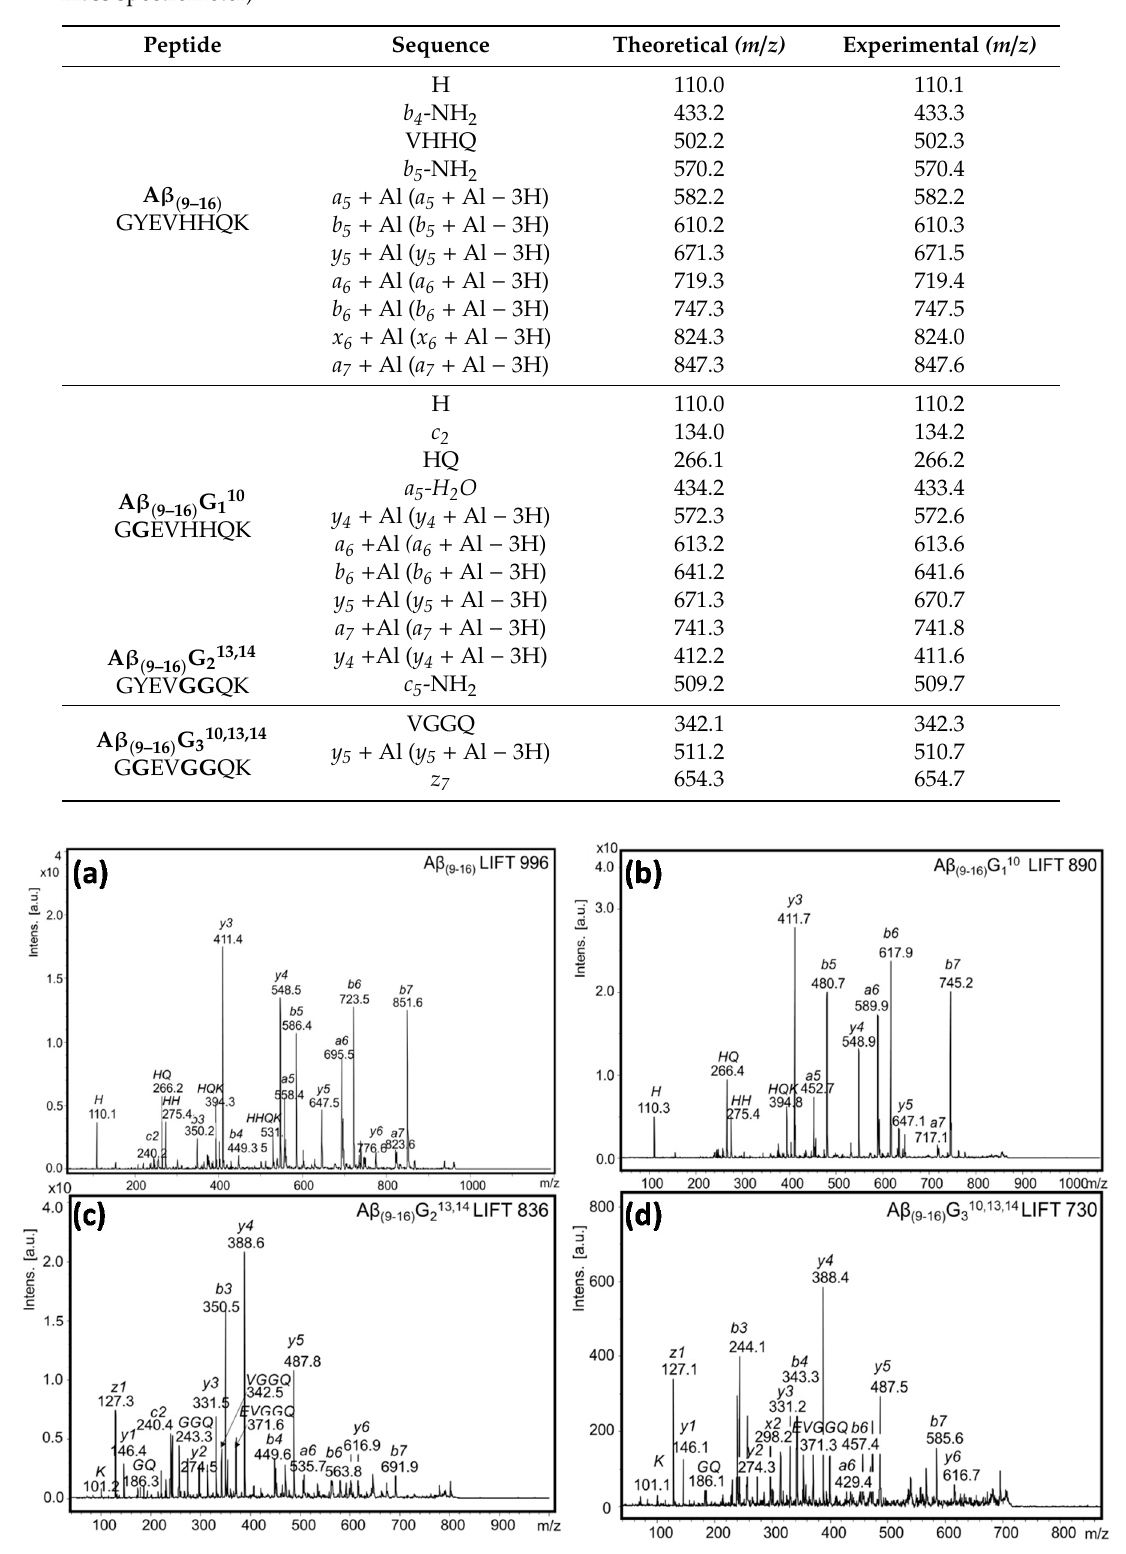
Figure 6. MS/MS spectra of the modified A β (9–16) peptides: ( a ) A β (9–16) ; ( b ) A β (9–16) G 110 ; ( c ) A β (9–16) G 213,14 ; ( d ) A β (9–16) G 310,13,14